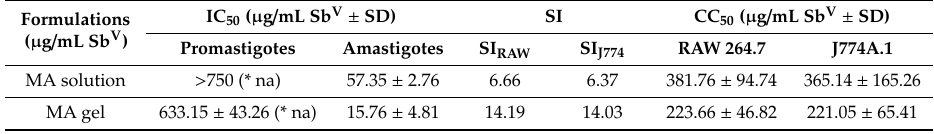
Figure 9. Cytotoxicity of MA solution and MA gel in cell lines ( A ) HaCaT, ( B ) RAW 264.7 and ( C ) J774A.1. Table 3. In vitro activity against promastigotes and amastigotes, and cytotoxicity of the reference MA solution and the MA gel and selectivity index (SI).